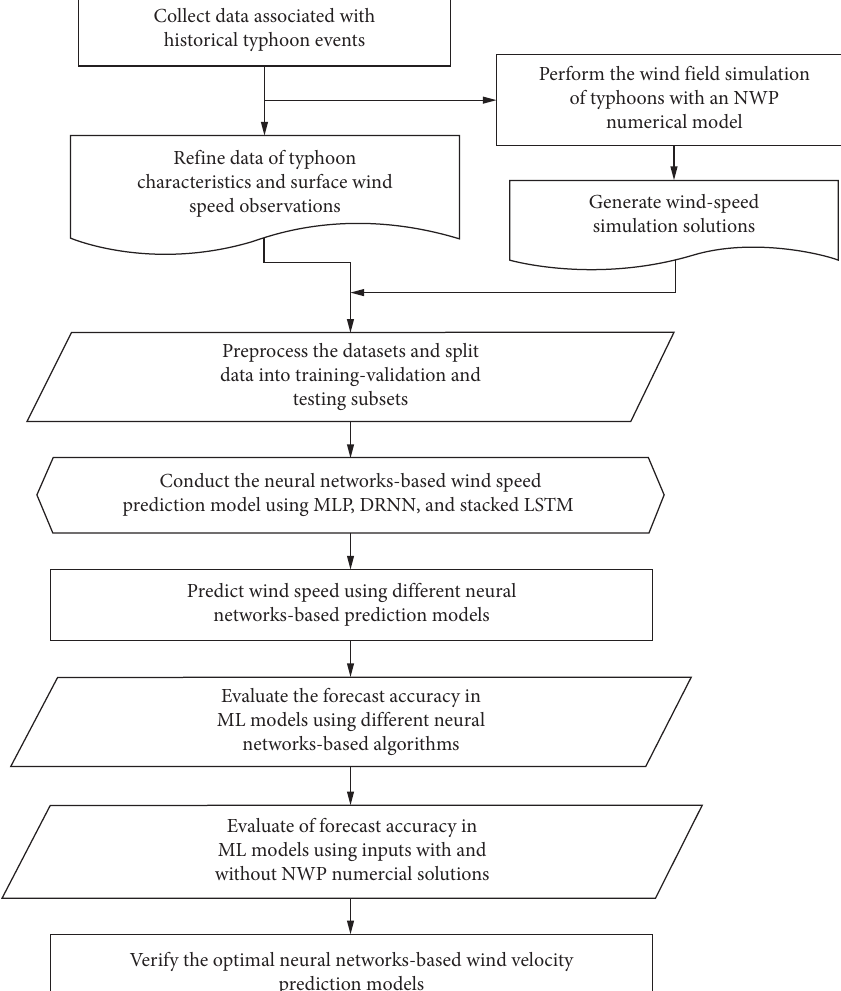
Figure 1: Flowchart of neural network-based typhoon wind velocity prediction model using NWP numerical